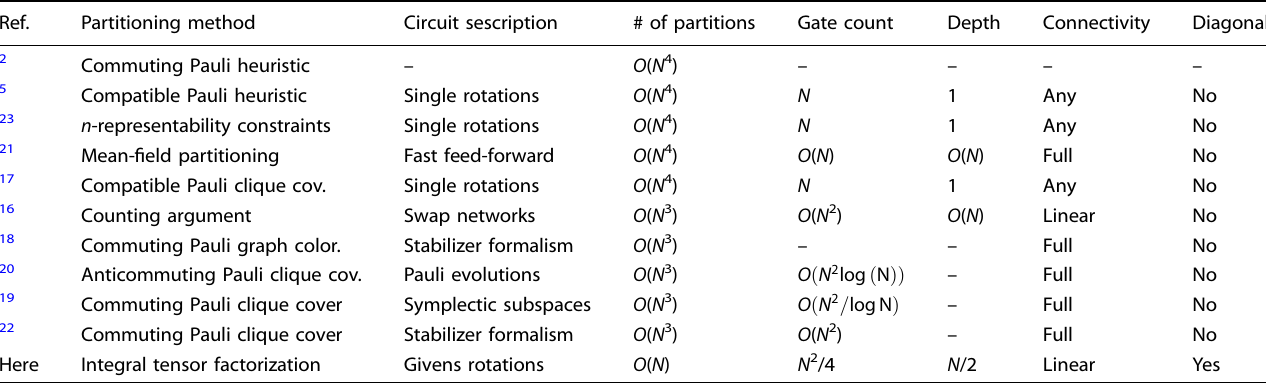
Table 1. A history of ideas reducing the measurements required for estimating the energy of arbitrary basis chemistry Hamiltonians with the variational quantum eigensolver.